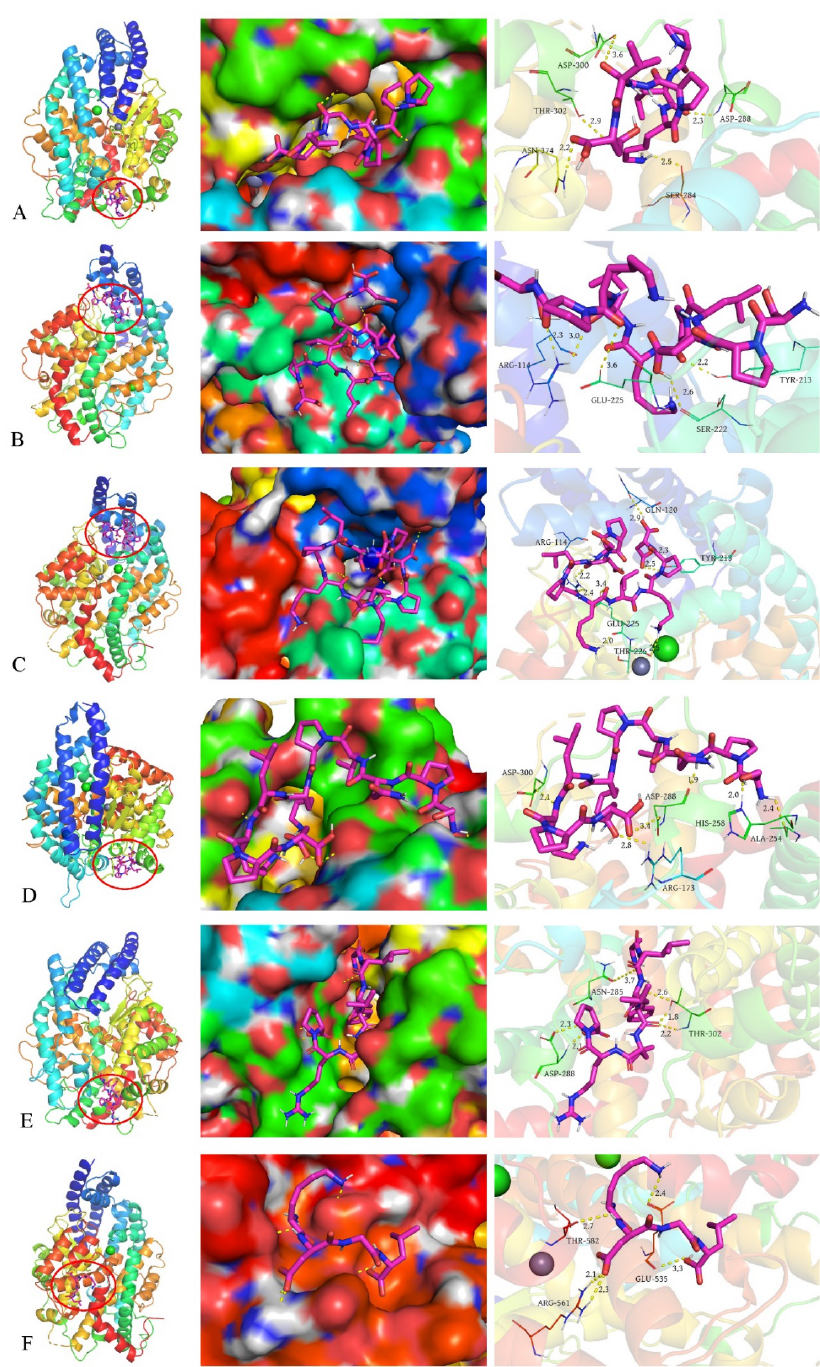
Figure 5. ( A – F ) shows the visualization results of the molecular docking of peptides 1–6 with ACE in order. On the left is a cartoon model of the binding of a ligand (peptide) to a receptor (ACE), in which the purple rod-like structure is the ligand (peptide) and the large molecule is the receptor (ACE). In the middle is the local enlargement of the binding of ligand (peptide) and receptor (ACE). The receptor (ACE) is in surface mode to better show the spatial structure, the ligand (peptide) is in stick cartoon mode to better show the interaction between the docked molecules, and the yellow dashed line is the hydrogen bond. On the right is a partial enlarged cartoon diagram of the binding of the ligand (peptide) to the receptor (ACE). The stick structure is the ligand (peptide), the line structure is the amino acid residue and the label next to it is the amino acid number of the receptor (ACE), and the yellow dashed line is the hydrogen bond and the label next to it is the bond